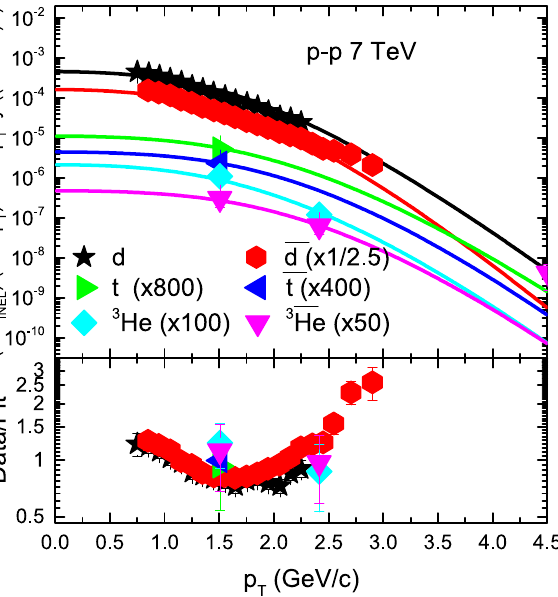
¯ d ¯ He , t , ¯ t , 3 He and 3 in | y | < 0.5